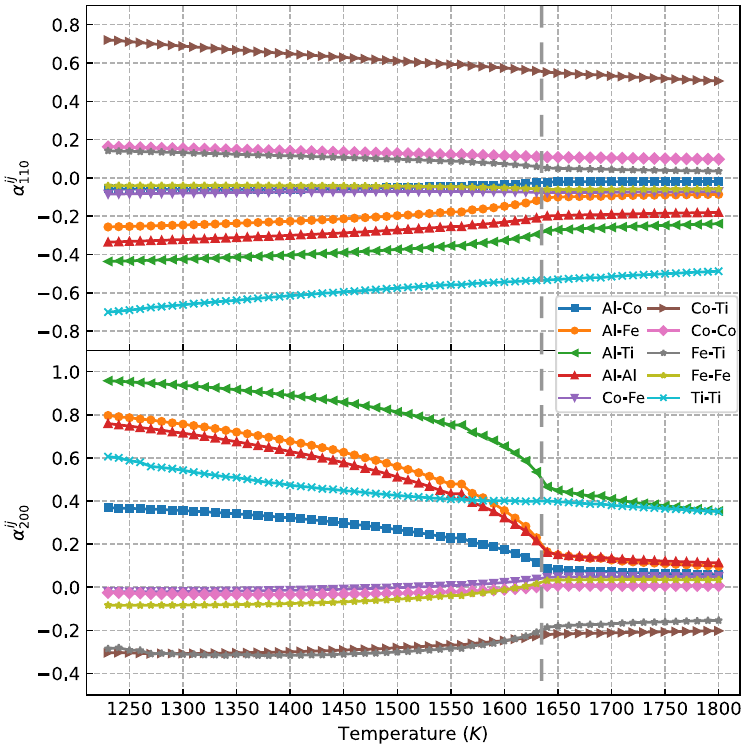
Figure 9. Atomic SRO parameters a ij of Co 25 Fe 25 Ni 25 Al 20 Ti 5 HEA at the first and second coor- lmn dination shells from Monte Carlo simulations with the solute interactions from DFT calculations. The dashed line shows the order–disorder transition